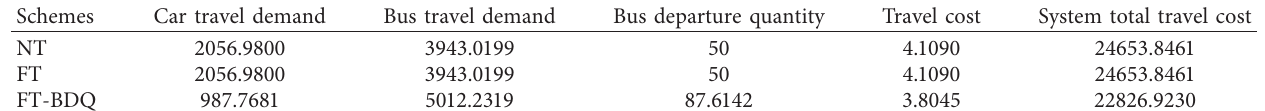
Table 3: Equilibrium results under three schemes.